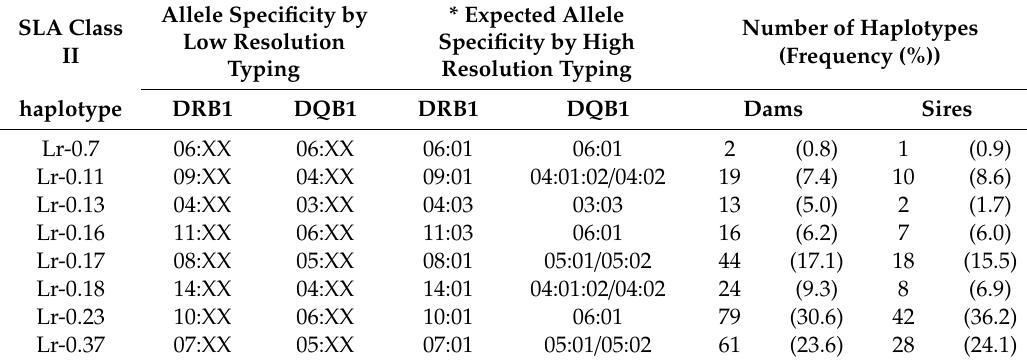
Table 1. SLA-class II genotypes and number of SLA class II haplotypes in